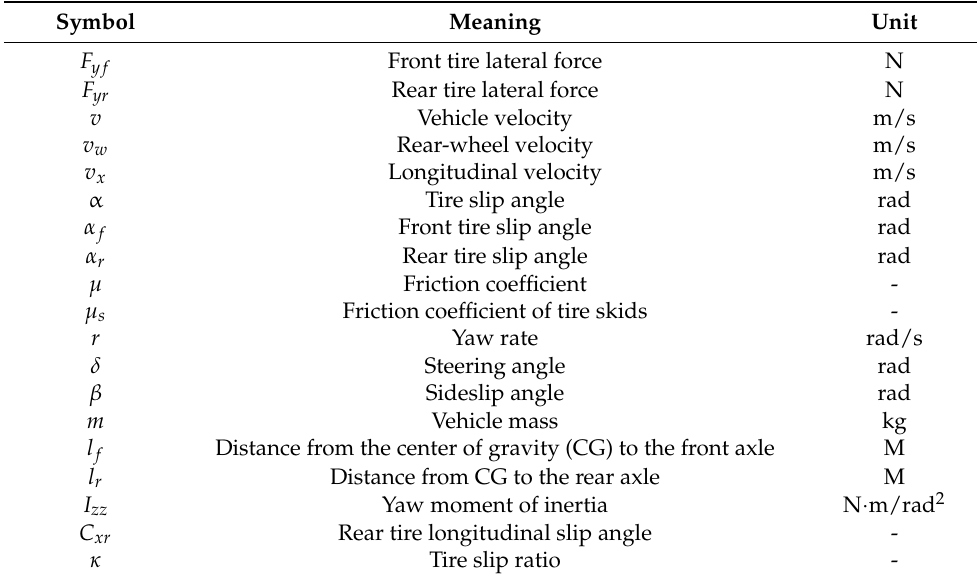
Table 1 defines the notations used in this study. The state variables of the vehicle model in Equation (1) are the sideslip angle ( β ), yaw rate ( r ), and forward velocity ( v x ). The control inputs are the rear tire force ( F xr ) and the steering angle ( δ ). Table 1. Nomenclature of the present